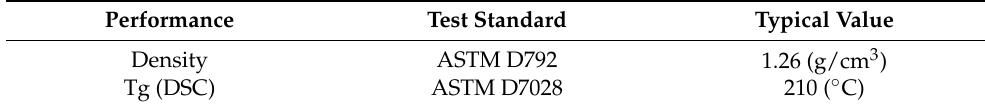
Table 1. Properties of EH918 resin.